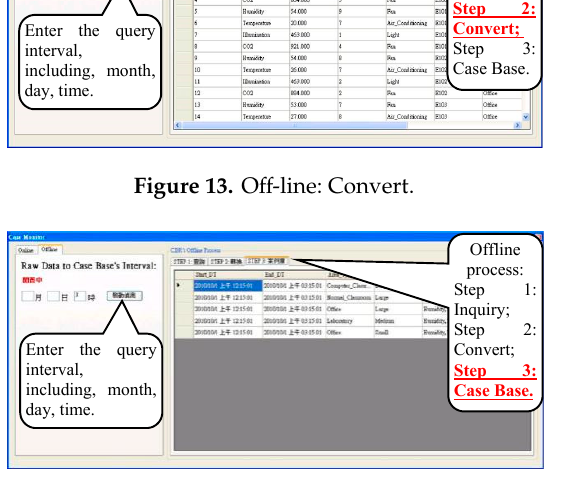
Figure 14. Off-line: Case Base.